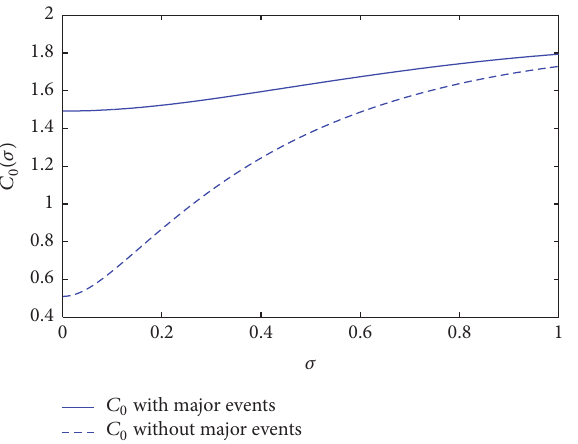
(𝑡 − 𝑡 ) = 1; 𝑉 1 = 1; 1 0 0 = 2. Figure 3(b):